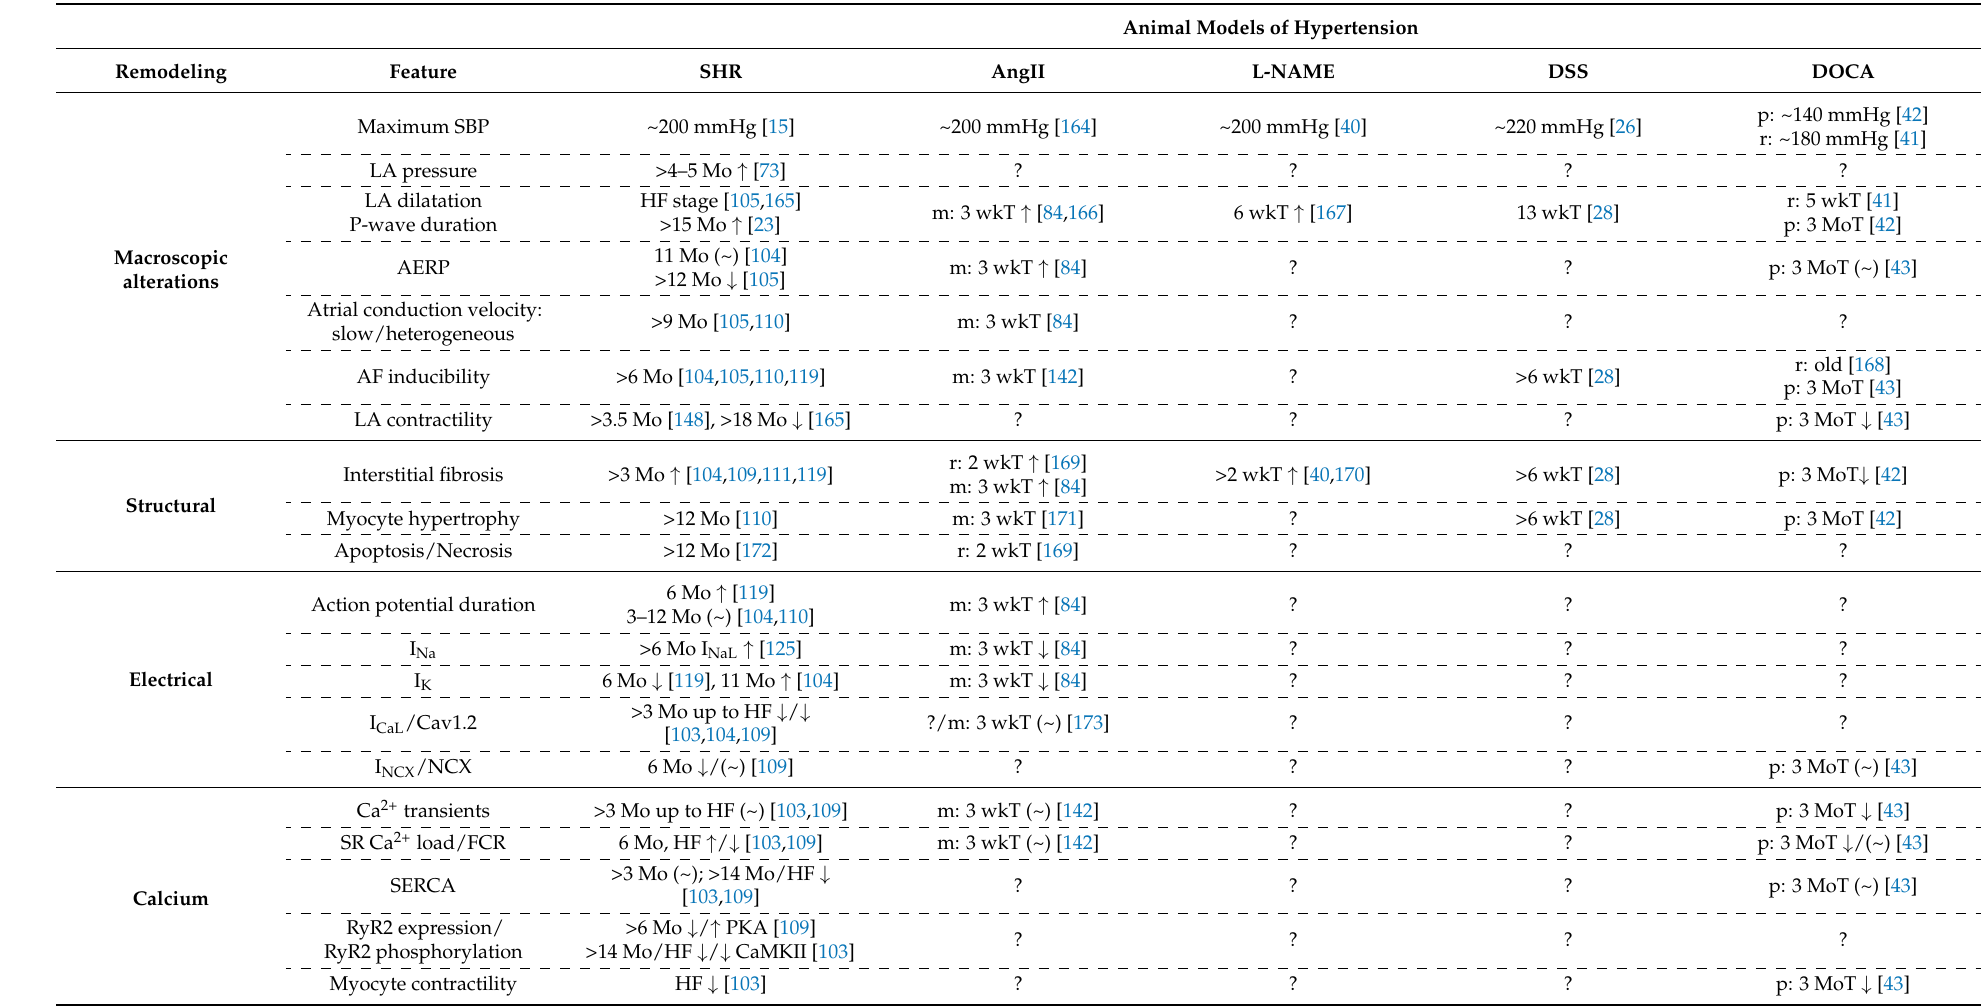
Table 1. Remodeling in some frequently used animal models of hypertension with a particular focus on atrial remodeling. Animal Models of